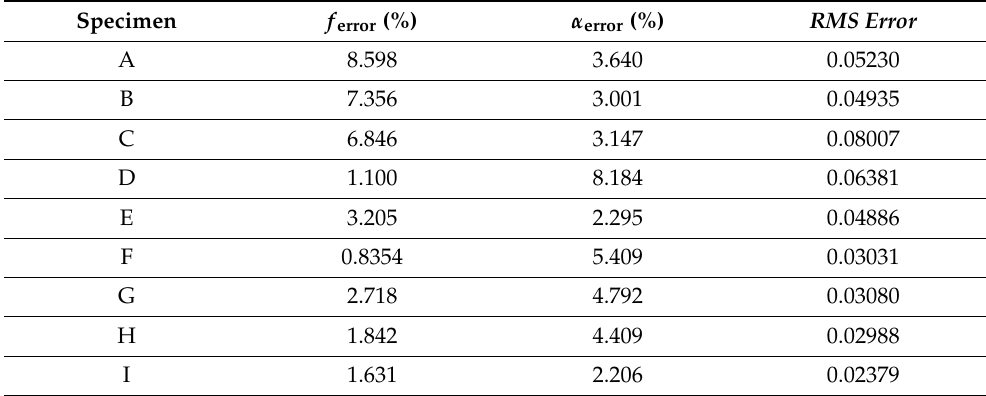
Table 6. Mean absolute values of the error indices (Equations (4)–(6)) for the four air-back cavity depth conditions for specimens